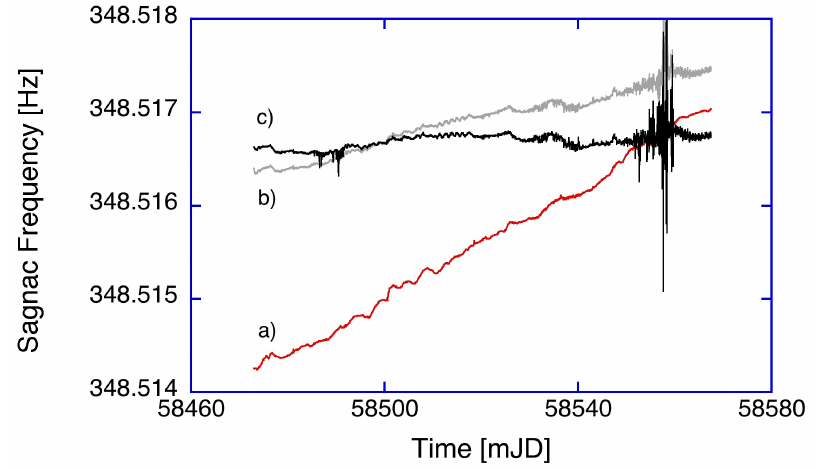
Figure 4. The backscatter corrected Earth rotation rate over 100 days of observation. Each data point was averaged over one hour and the known geophysical signals have been removed from the measurements. The abscissa shows the measured Sagnac frequency with (a) representing the raw data; (b) the same dataset after the correction for the backscatter coupling. The final result is shown in (c) when dispersive effects from the drifting optical frequency are